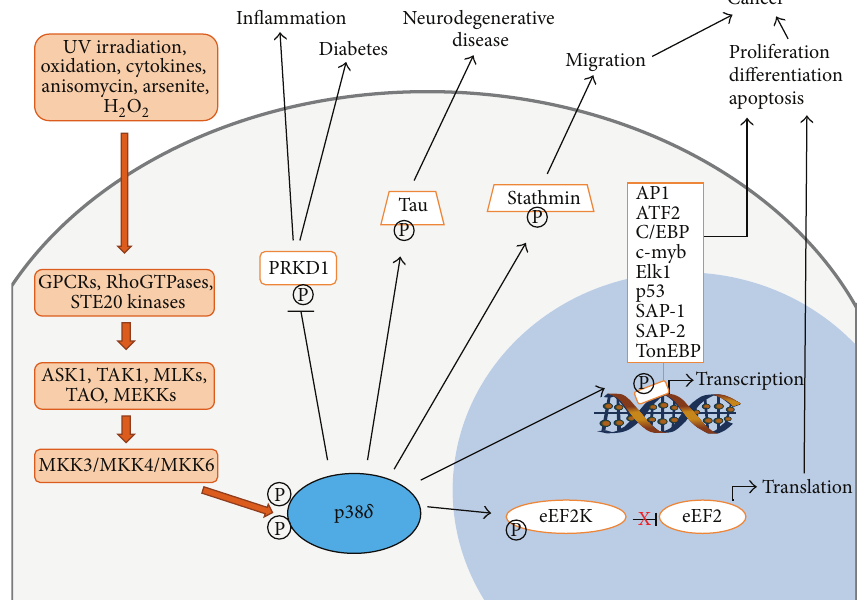
Figure 1: Schematic representation of the current understanding of p38 𝛿 MAPK signalling and activation. A variety of extracellular stimuli can activate the MAPK signalling pathway resulting in dual phosphorylation of p38 𝛿 MAPK. Known substrates of active p38 𝛿 MAPK include transcription factors, structural proteins, kinases, and translation repressors. Phosphorylated substrates affect several cellular processes and contribute to the pathogenesis of diseases such as cancer, diabetes, and neurodegenerative and inflammatory